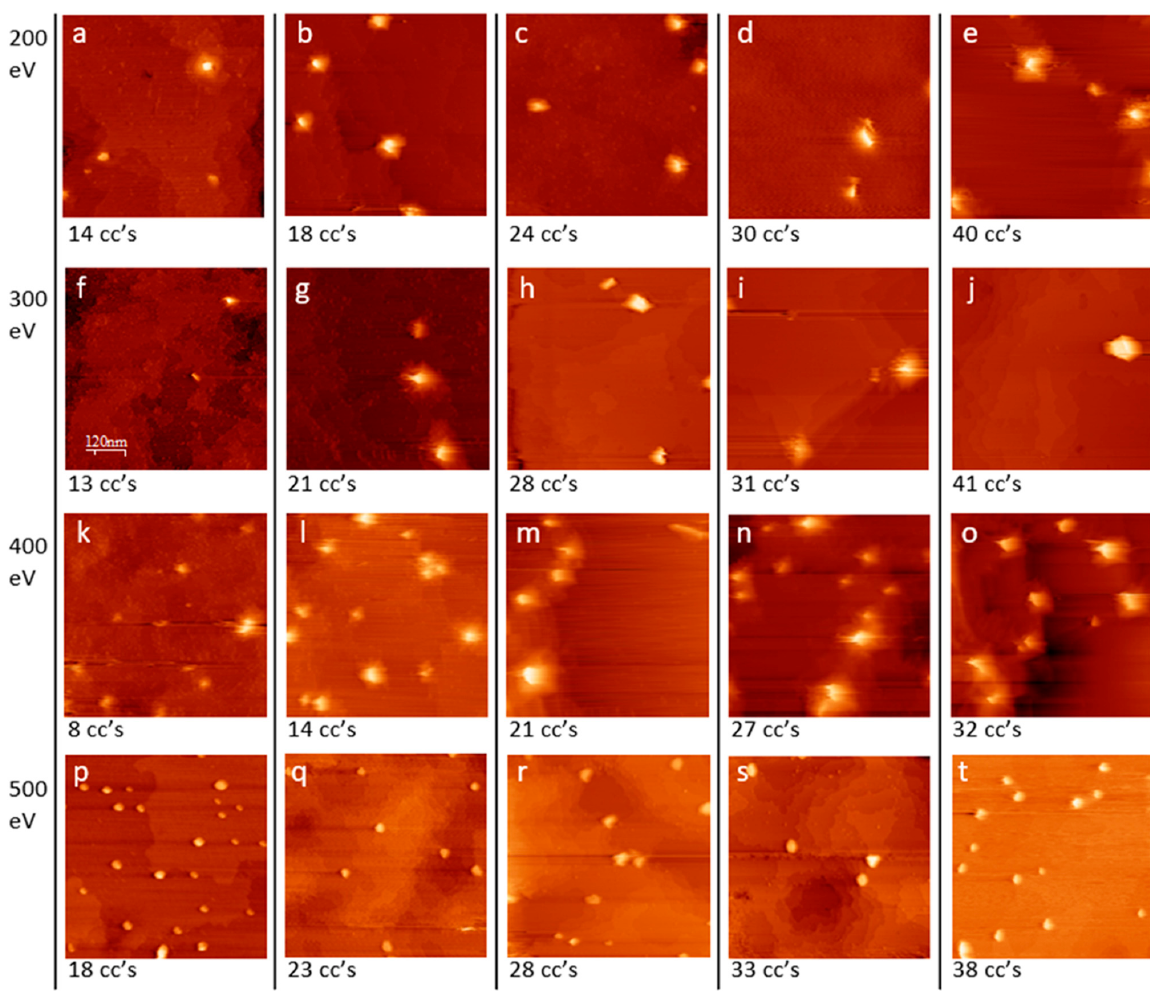
Figure 3. STM topographical images of bare Ge (110) samples with number of cleaning cycles (cc’s) shown beneath each image. Cleaning was performed in Ag-coated sample holders using Ar+ with energies and fluence ranges of ( a – e ) 200 eV, 2.8 × 10 17 cm − 2 to 7.9 × 10 17 cm − 2 ; ( f – j ) 300 eV, 3.7 × 10 17 cm − 2 to 1.2 × 10 18 cm − 2 ; ( k – o ) 400 eV, 2.9 × 10 17 cm − 2 to 1.2 × 10 18 cm − 2 ; and ( p – t ) 500 eV, 8.1 × 10 17 cm − 2 to 1.7 × 10 18 cm- 2 . Imaging parameters 0.5 nA, 2 V tip bias. Image sizes ( a ) 300 nm × 300 nm; ( b – t ) 600 nm × 600 nm.